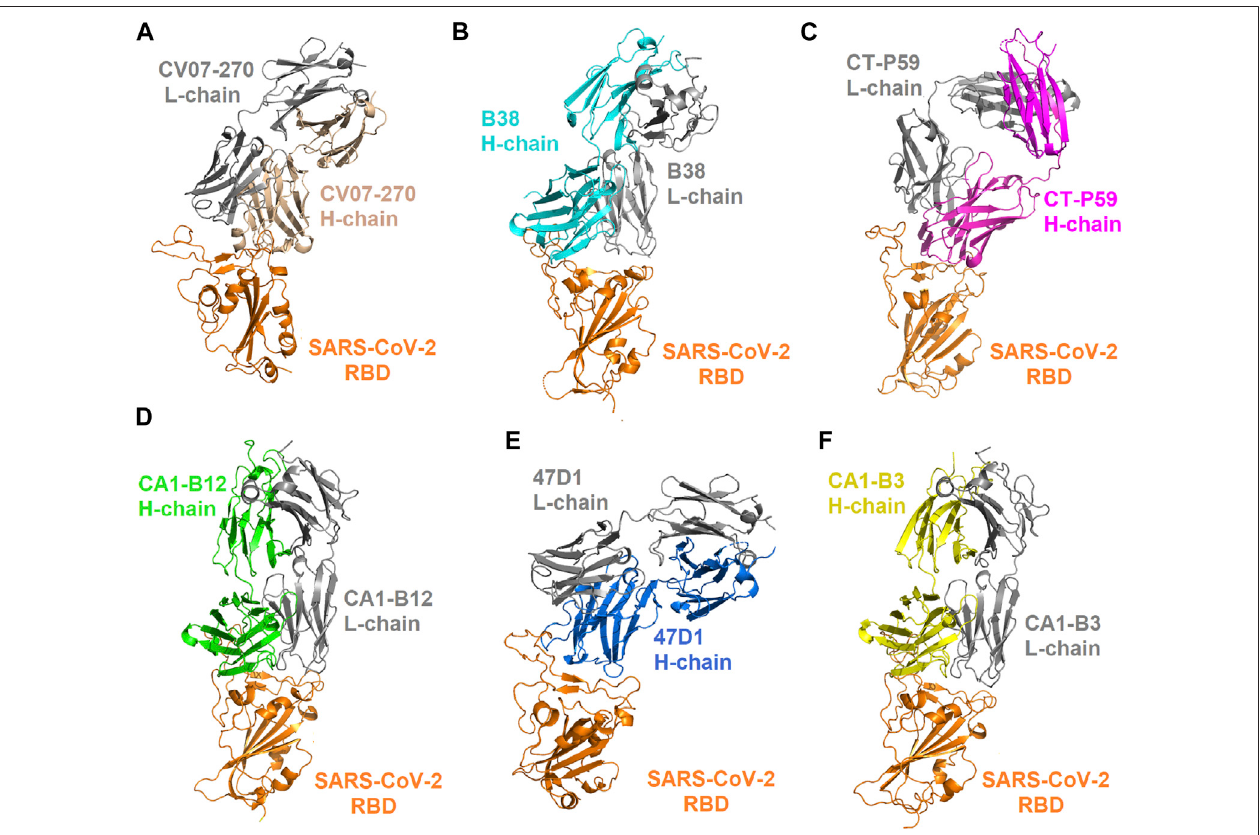
FIGURE 1 | Complex structures of the SARS-CoV-2 RBD bound with convalescent antibodies. (A) The complex structure of the RBD – CV07-270 antibody (PDB ID:6XKP). (B) ThestructureoftheRBDincomplexwiththeB38antibody(PDBID:7BZ5). (C) ThestructureoftheRBDboundwiththeCT-P59antibody(PDBID:7CM4). (D) ThestructureoftheCA1-B12antibodyincomplexwiththeRBD(PDBID:7KFV). (E) Thestructureofthe47D1antibodyboundwiththeRBD(PDBID:7MF1). (F) The structure of the CA1-B3 antibody in complex with the RBD (PDB ID: